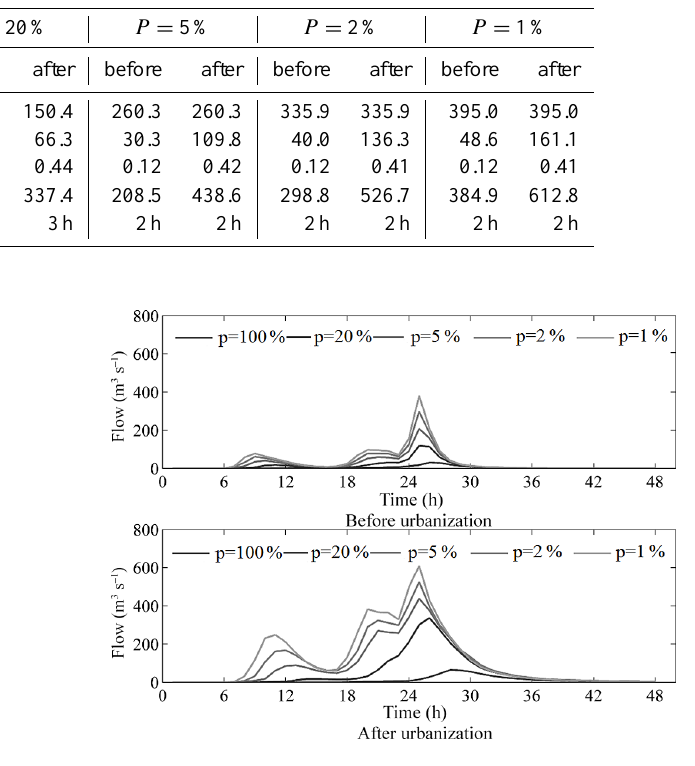
Figure 7. Changes of floods in different urbanization